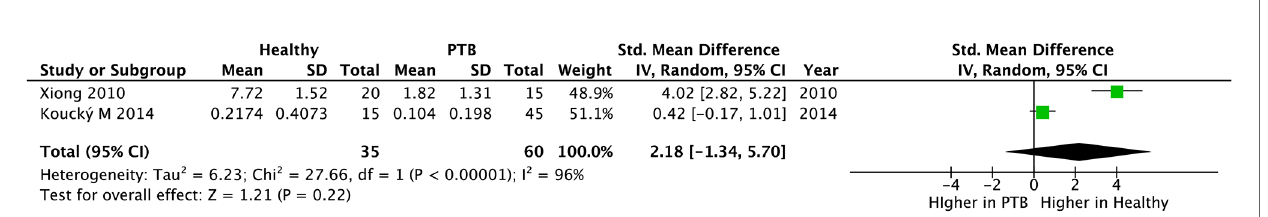
FIGURE 5 | Standardized mean difference of T regulatory cell numbers in the peripheral blood of healthy pregnant women and women who underwent preterm birth (PTB). PTB, preterm birth; CI, con fi dence interval; SD, standard deviation; Std. Mean Difference, standardised mean difference; IV,